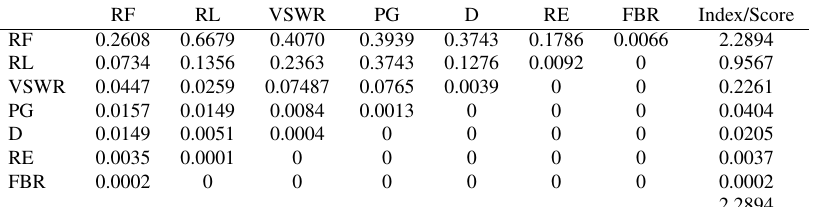
Table 5: AHP: Step3